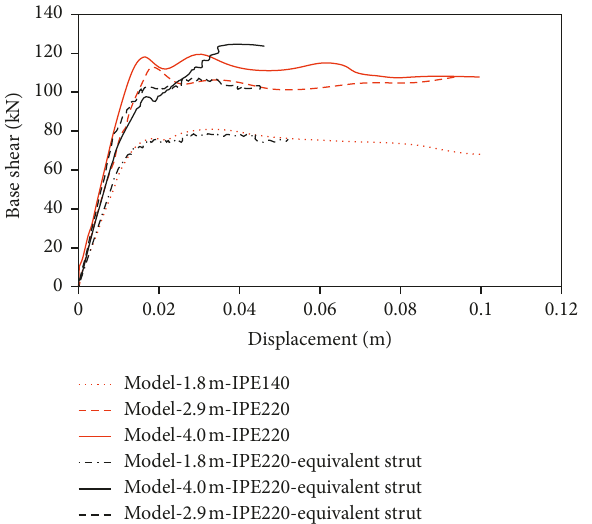
Figure 13: Comparison of the force-displacement diagrams of the IPE220-series finite element models with those of the equivalent strut